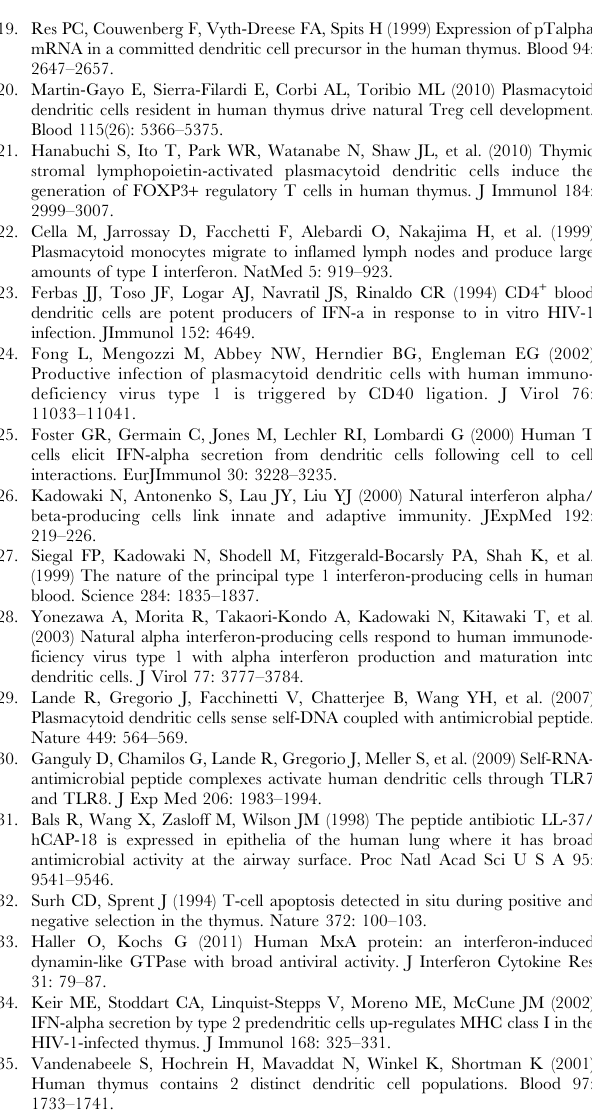
Figure S2 Thymic pDC constitutively express high levels of IFN- a mRNA. mRNA was prepared from postnatal total thymocytes, BCDA4-MACS enriched pDC and the BDCA4 negative fraction, and from sorted pDC. Q-PCR was performed for IFN- a mRNA. Figure S3 pDC from post-natal and fetal thymus express MxA, but not pDC from fetal spleen or fetal lymph node or adult PBMC. Cells from fetal tissues or adult PBMC were stained for surface expression of CD123, CD3 and CD45RA and intracellular expression of MxA. MxA expression in pDC was determined by gating on CD45RA + CD123 + /hi cells.